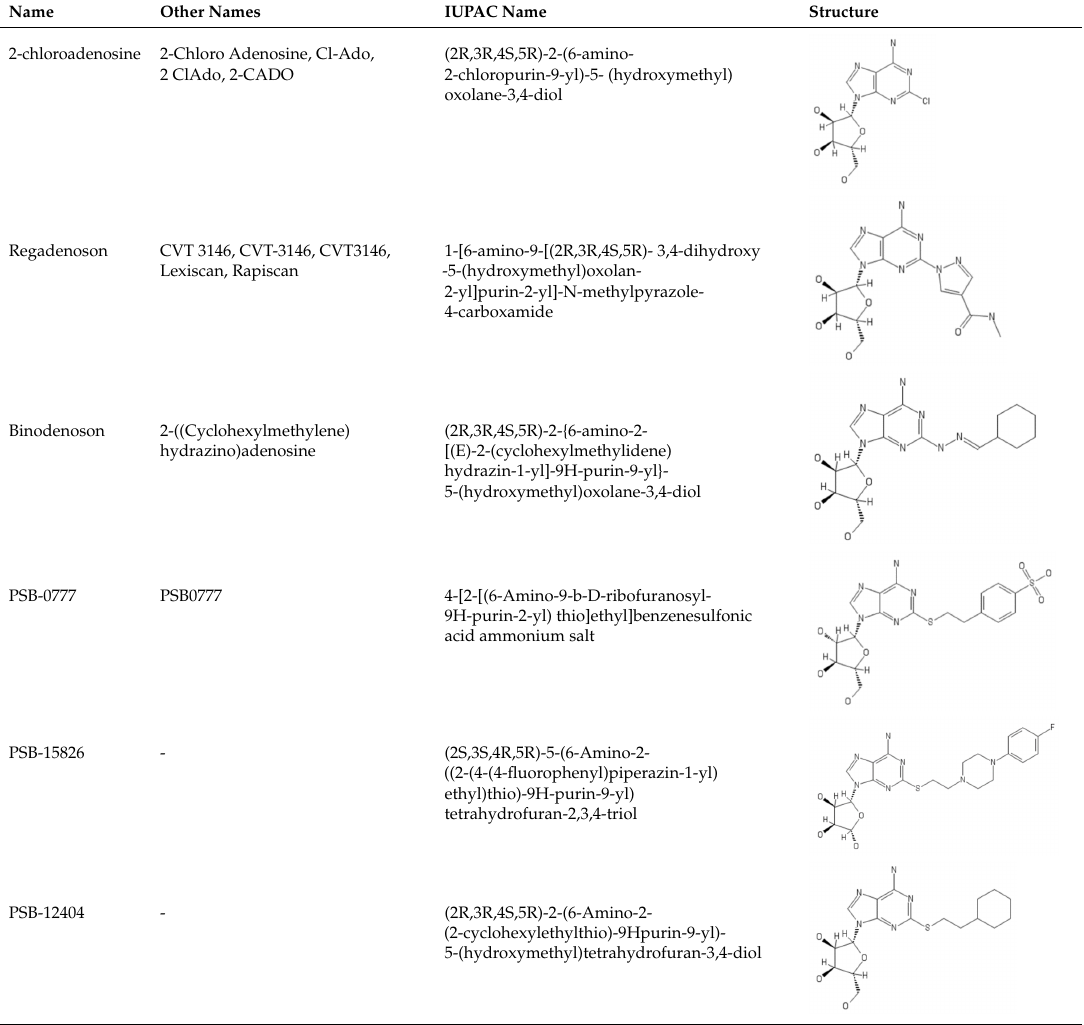
Table 2. Nomenclature and chemical structure of AR agonists.